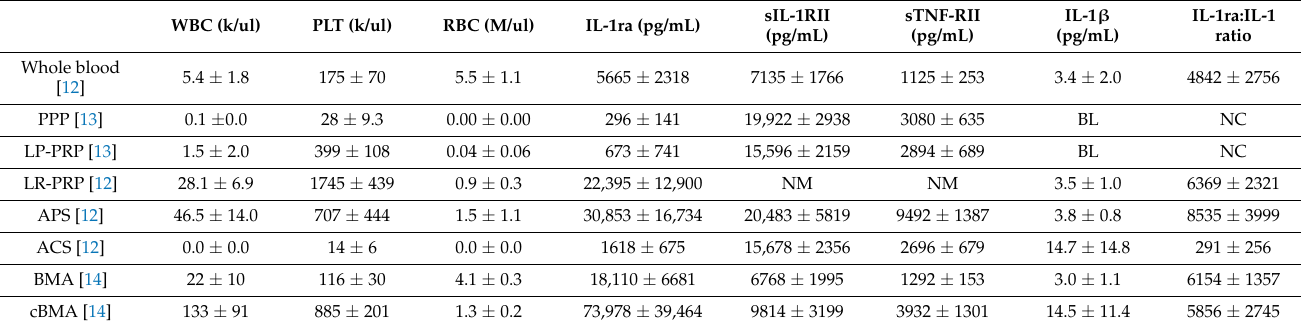
Table 1. Complete blood counts (CBC) of common autologous therapies. (PPP: platelet-poor plasma; LP-PRP:leucocyte-poor platelet-rich plasma; LR-PRP: leucocyte-rich platelet-rich plasma; APS: autologous protein solution; ACS: autologous conditioned serum; BMA: bone marrow aspirate; cBMA: concentrated bone marrow aspirate; BL: below lower limit; NC: not calculated, NM: not